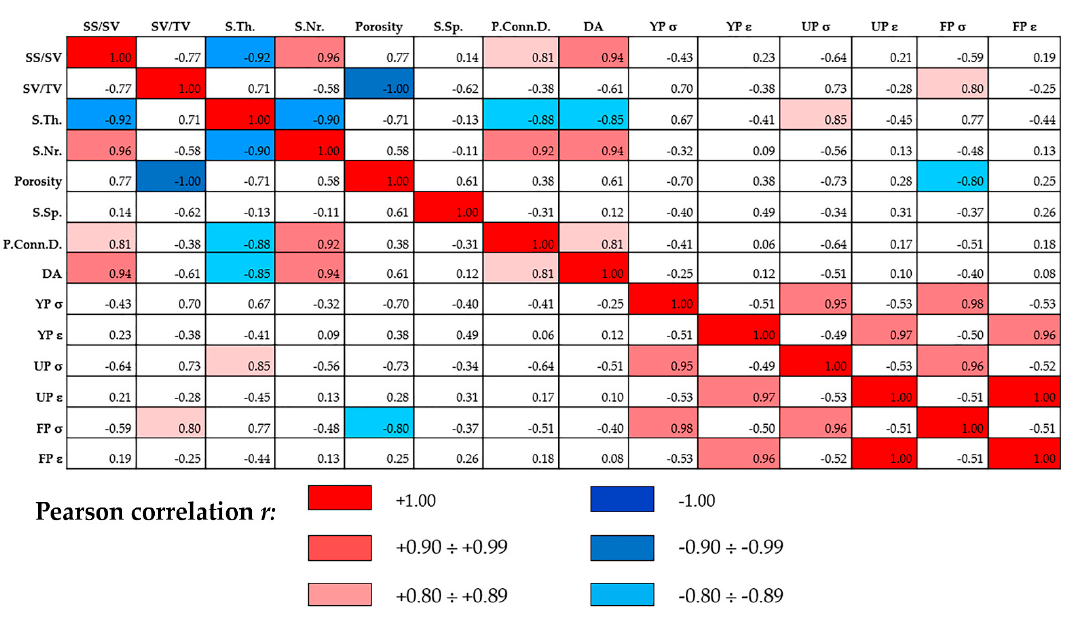
Figure 3. Pearson’s correlation coefficients of quantitative microCT and compressive test parameters. YP = Yield Point; UP = Ultimate Point; FP = Fracture Point.